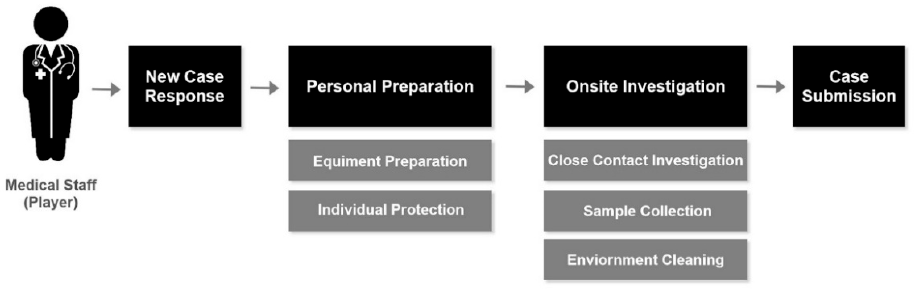
Figure 2. COVID-19 Education System Storyline.